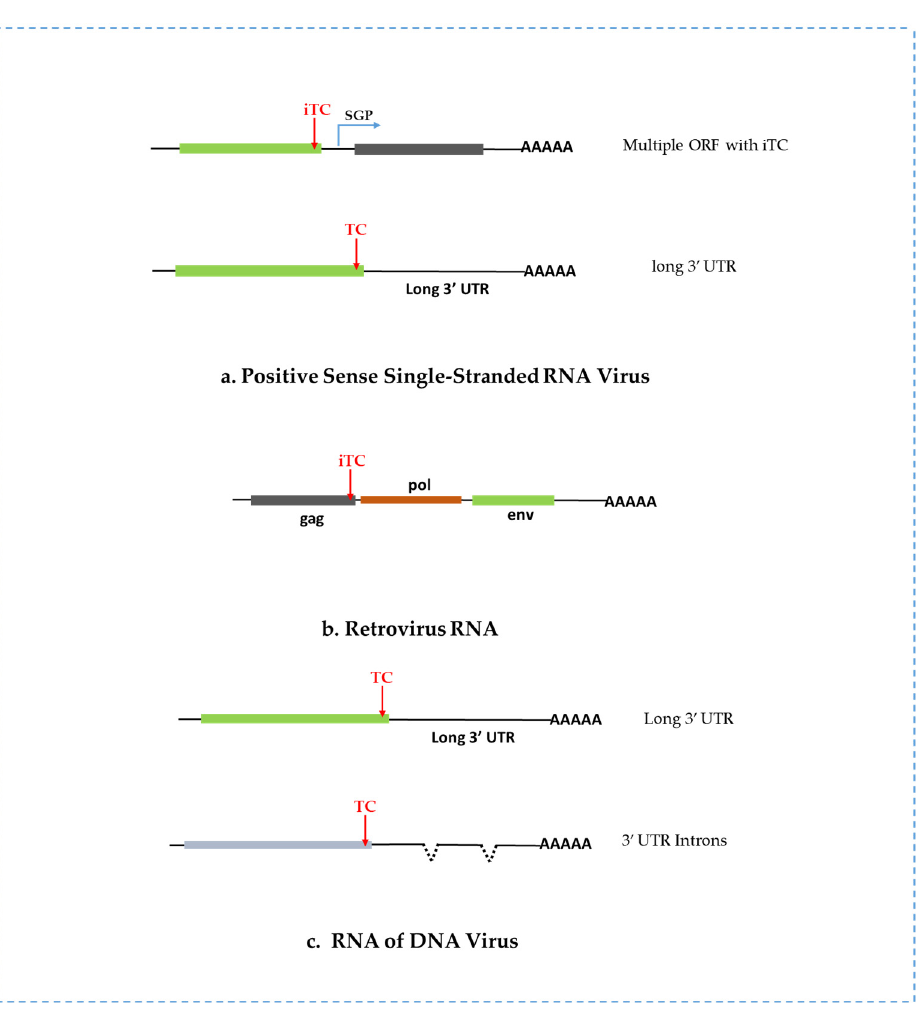
Figure 2. Schematic diagram of various viral RNAs targeted by host NMD: ( a ) Positive sense RNA virus possesses two or more separated open reading frames (e.g., semliki forest virus and sindbis virus) or a long 3 ′ UTR (e.g., pea enation mosaic virus 2); ( b ) Retroviral RNA (e.g., HIV, Rous Sarcoma Virus ) harboring internal termination codons (iTC) in the gag gene; ( c ) Susceptible RNAs of DNA